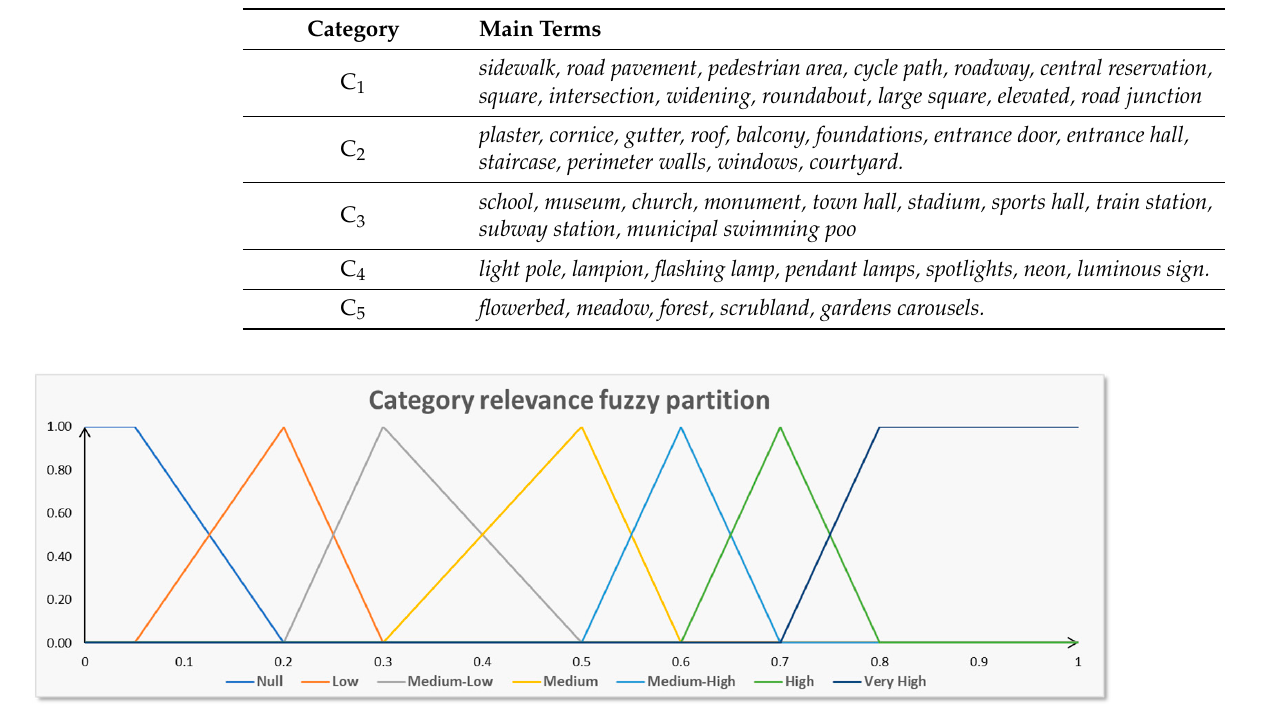
Figure 5. Category relevance fuzzy partition.